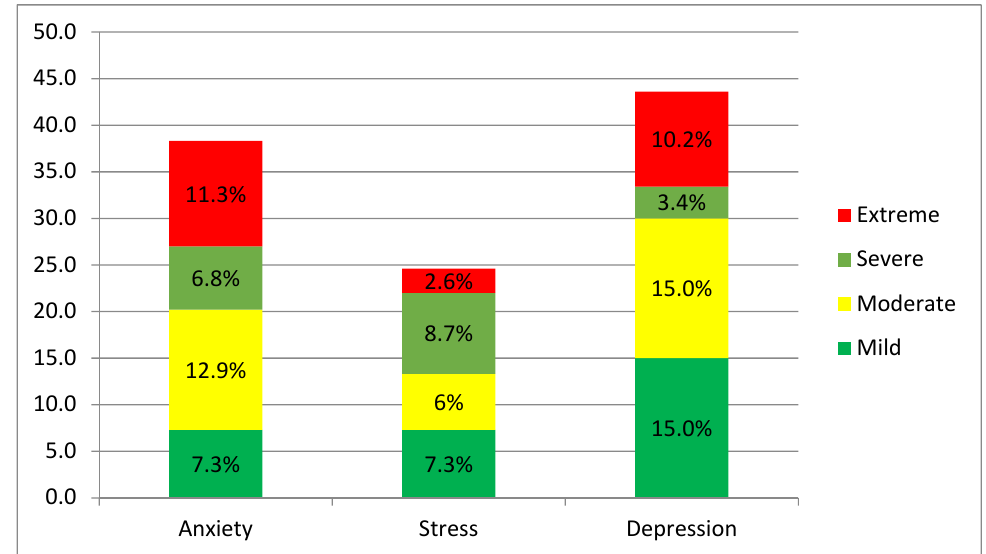
Figure 1. International students’ experience of anxiety, stress, and depression during COVID-19 pandemic in China .